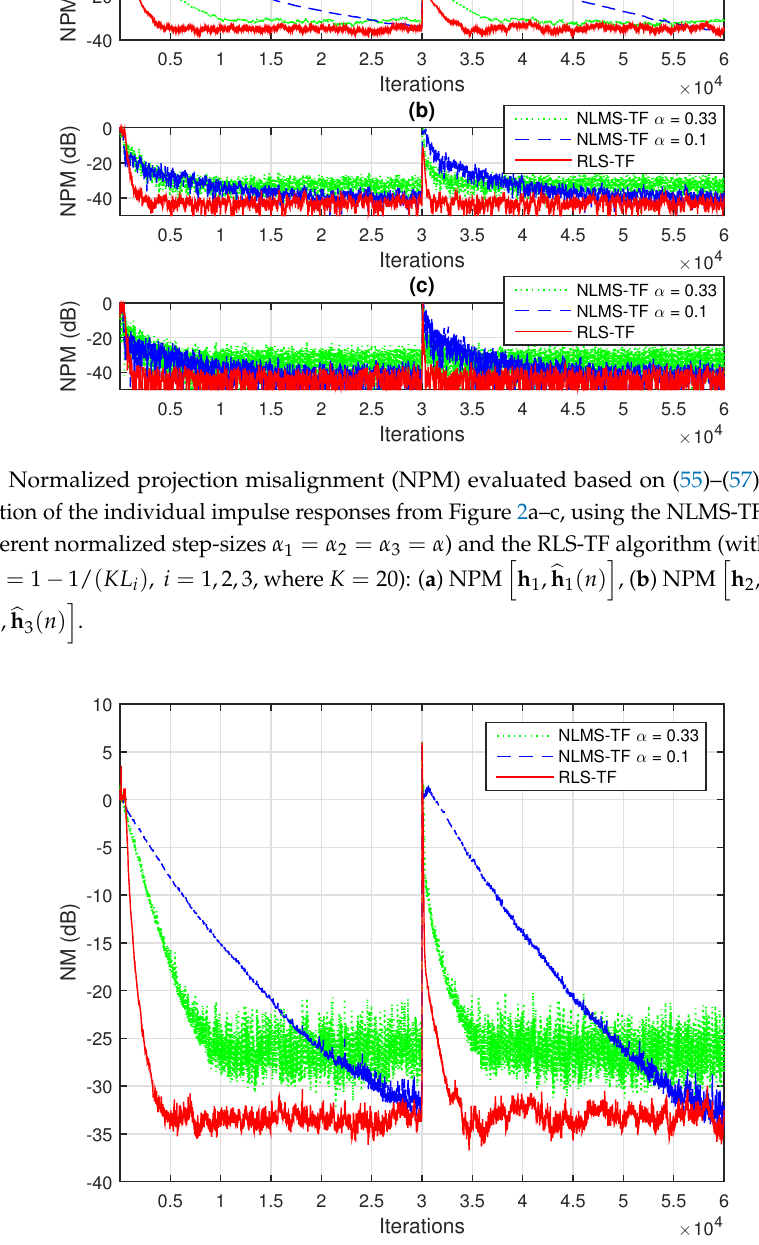
Figure 6. Normalized misalignment (NM) evaluated based on (58), in dB, for the identification of the global impulse response h (of length L = 2048) from Figure 2d, using the NLMS-TF algorithm [17] (with different normalized step-sizes α 1 = α 2 = α 3 = α ) and the RLS-TF algorithm (with the forgetting factors λ i = 1 − 1/ ( KL i ) , i = 1,2,3, where K =